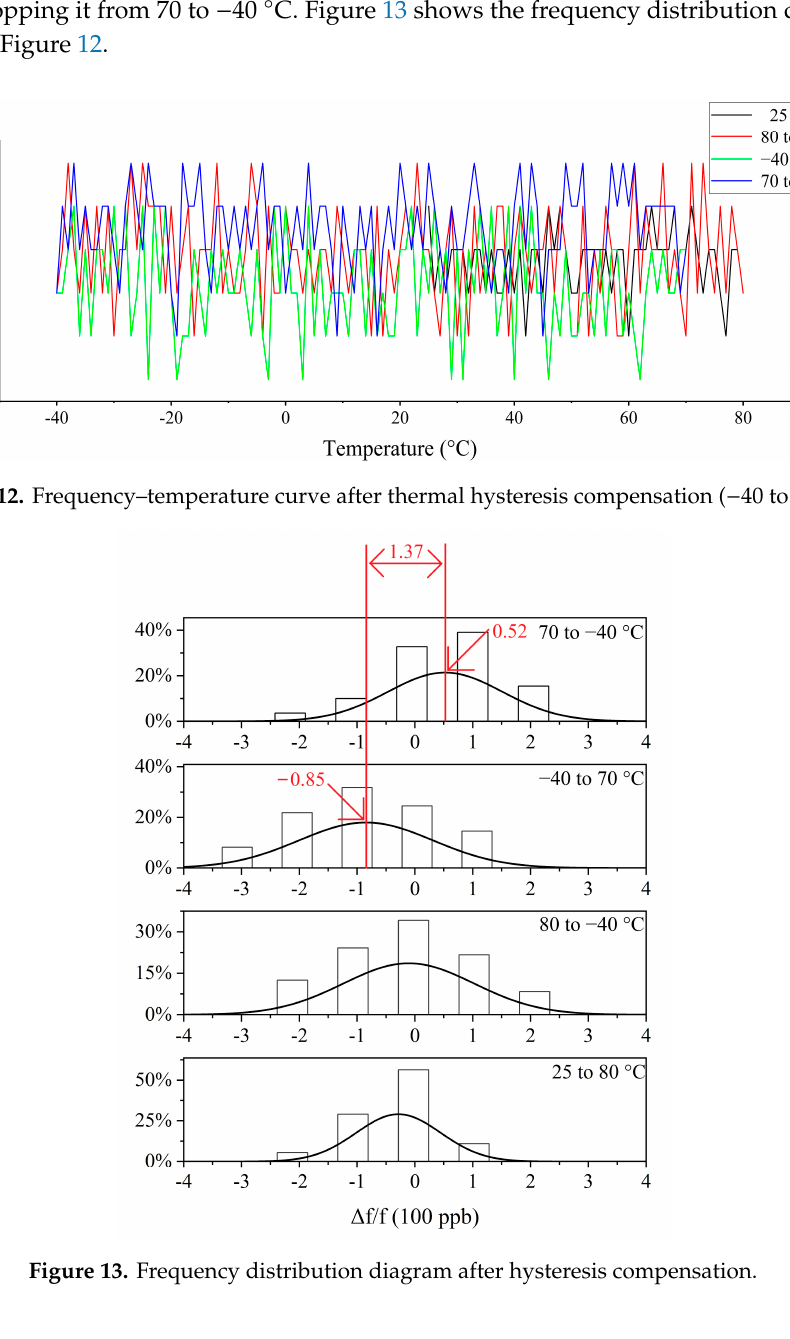
Figure 13. Frequency distribution diagram after hysteresis compensation.